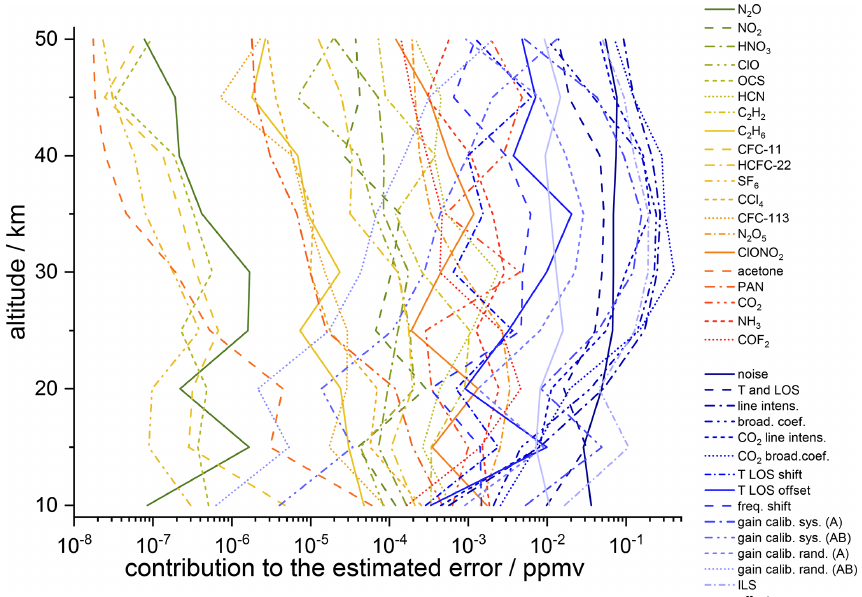
Figure 2. The error budget (absolute values) of a MIPAS ozone retrieval from a limb scan recorded at 40 . 09 ◦ N, 11.28 ◦ E during Envisat orbit 38517 on 12 July 2009 at